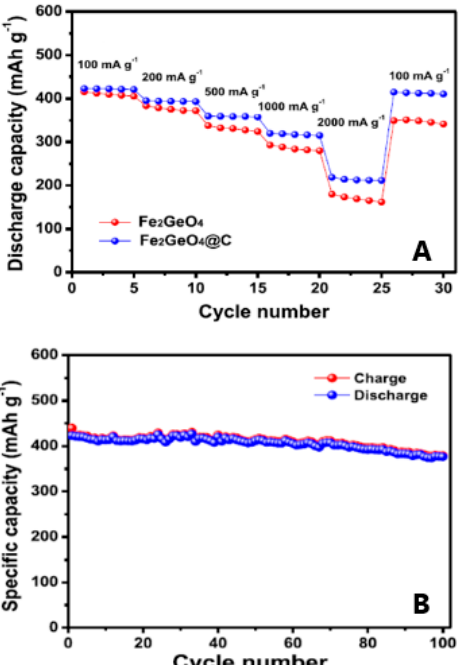
Figure 9. ( A ) Discharge capacities of GFO and GFO@C electrodes with increasing C rate; ( B ) Charge and discharge capacities of GFO@C electrode as a function of the cycle number (current rate: 100 mA g − 1 ) [28]. Reproduced with permission, Copyright Elsevier 2019.